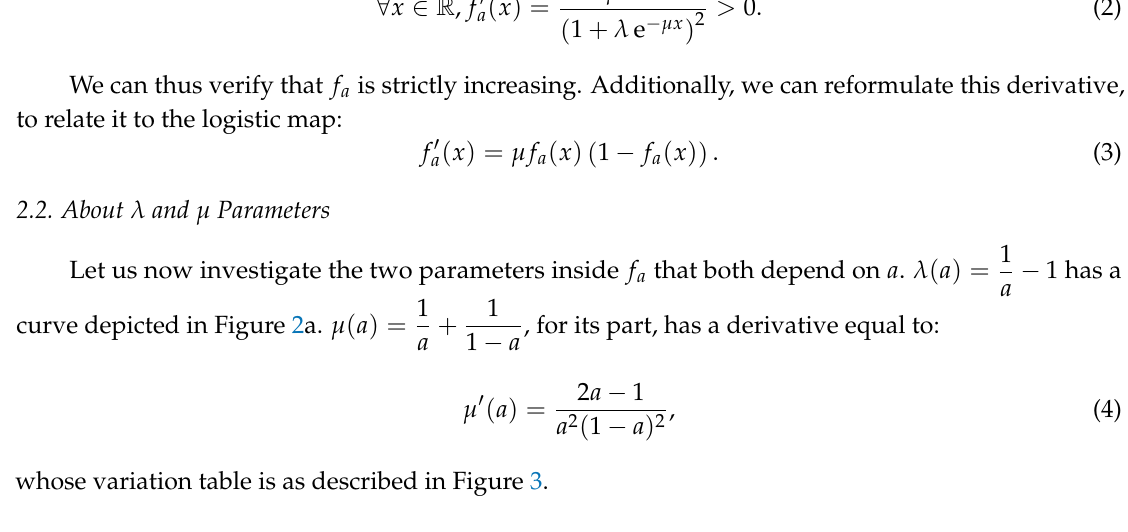
Figure 1. Graph of the sigmoid function f a ( x ) = a ∈ ] 0,1 [